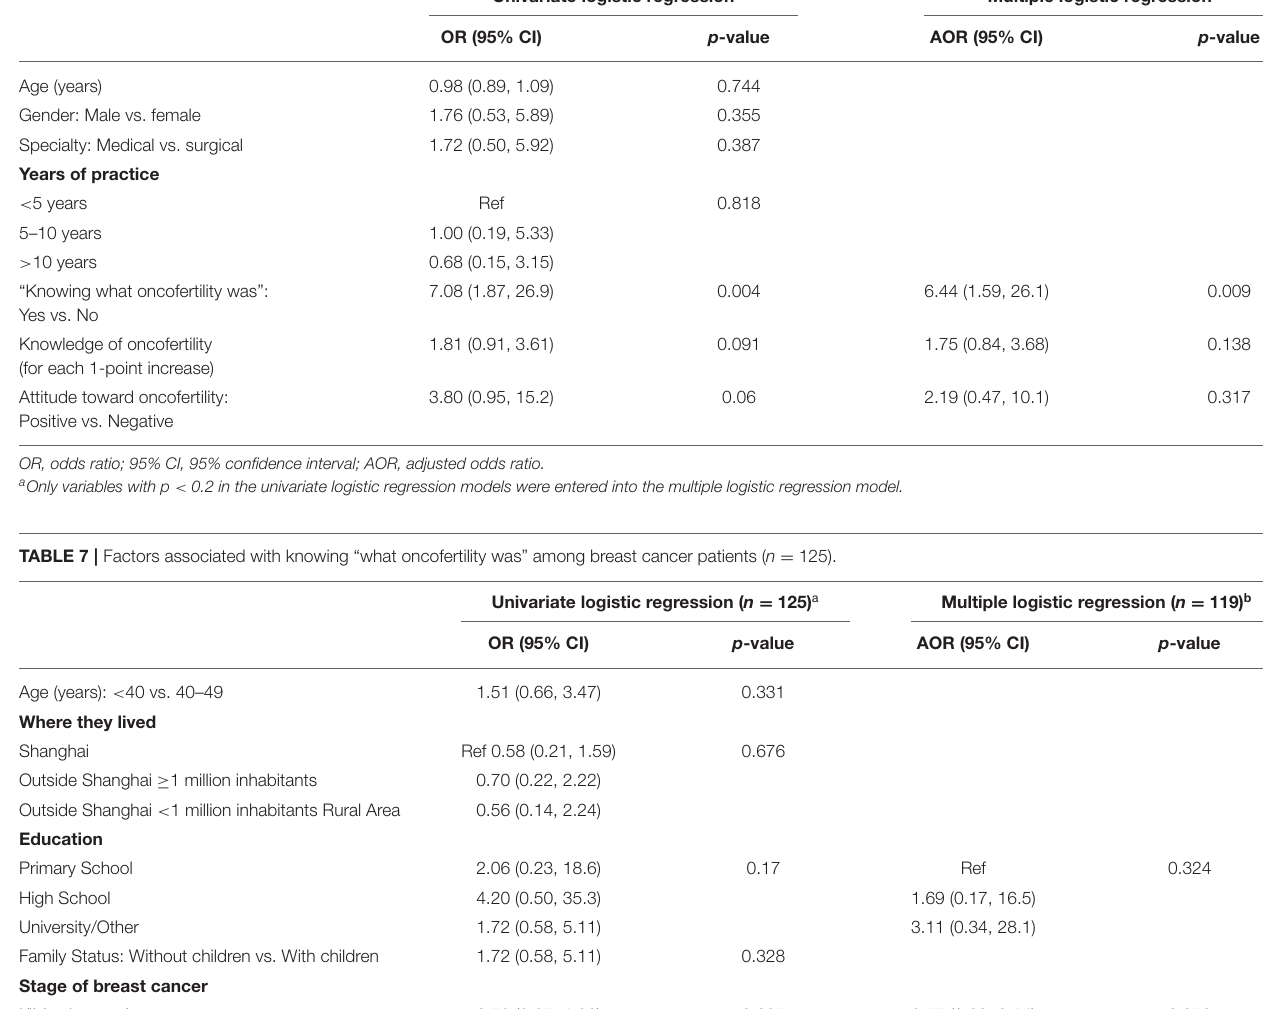
TABLE 6 | Factors associated with “discussing oncofertility” with reproductive-aged patients among oncologists ( n = 61). Univariate logistic regression Multiple logistic regression a